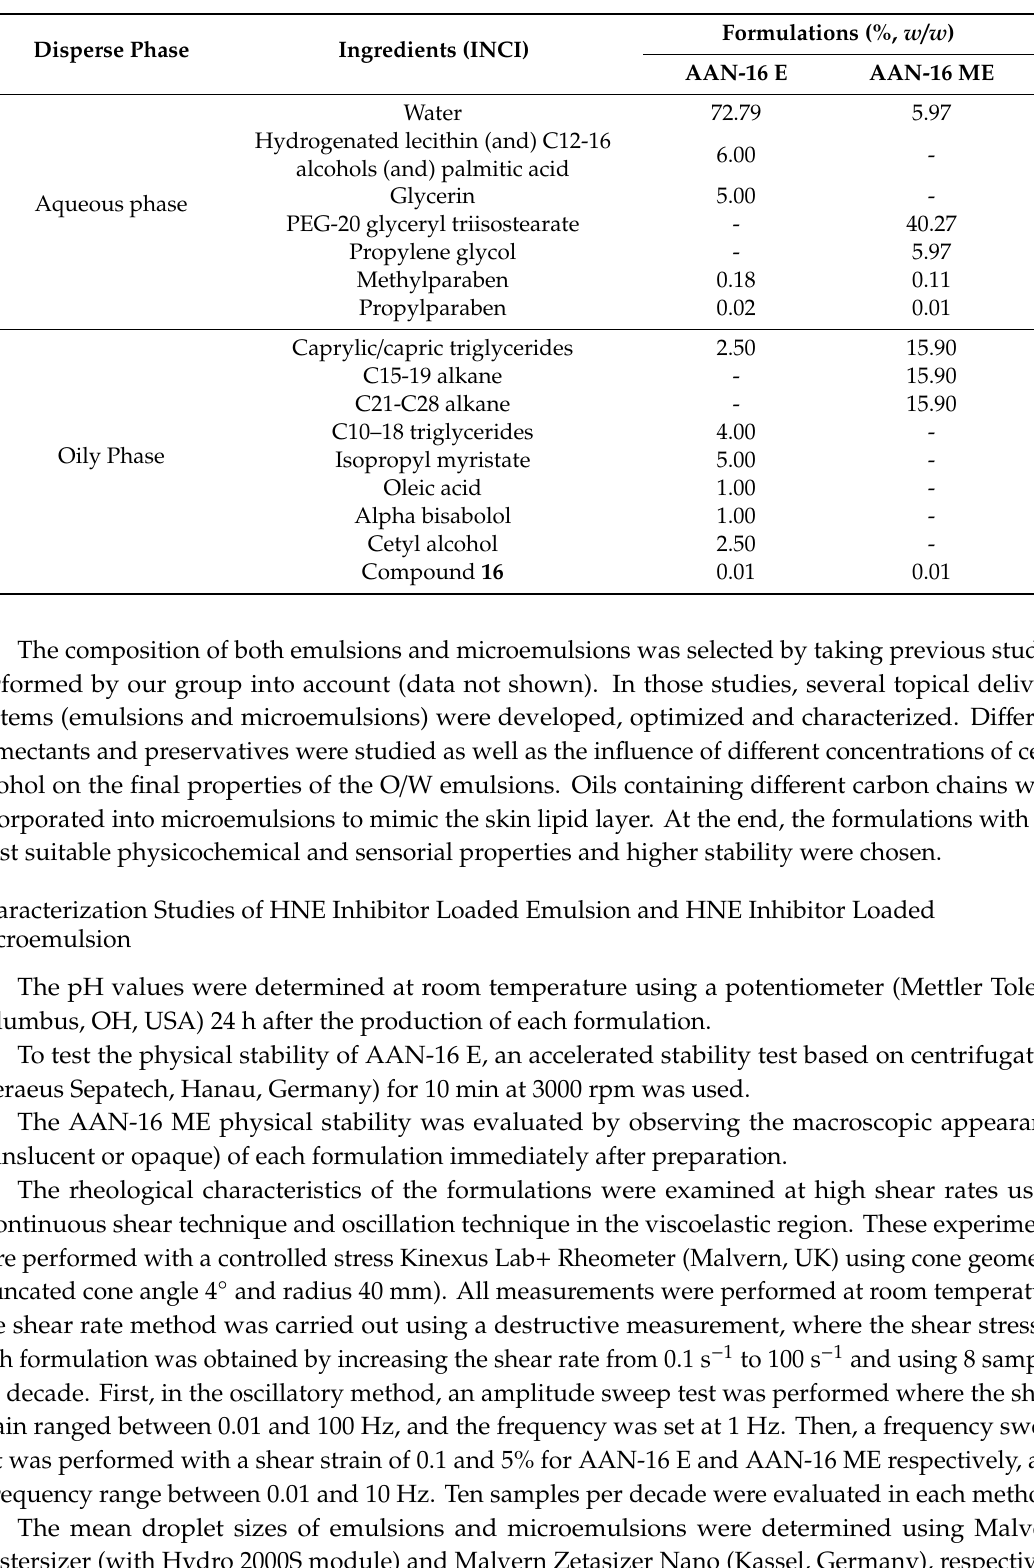
Table 1. Qualitative and quantitative composition of